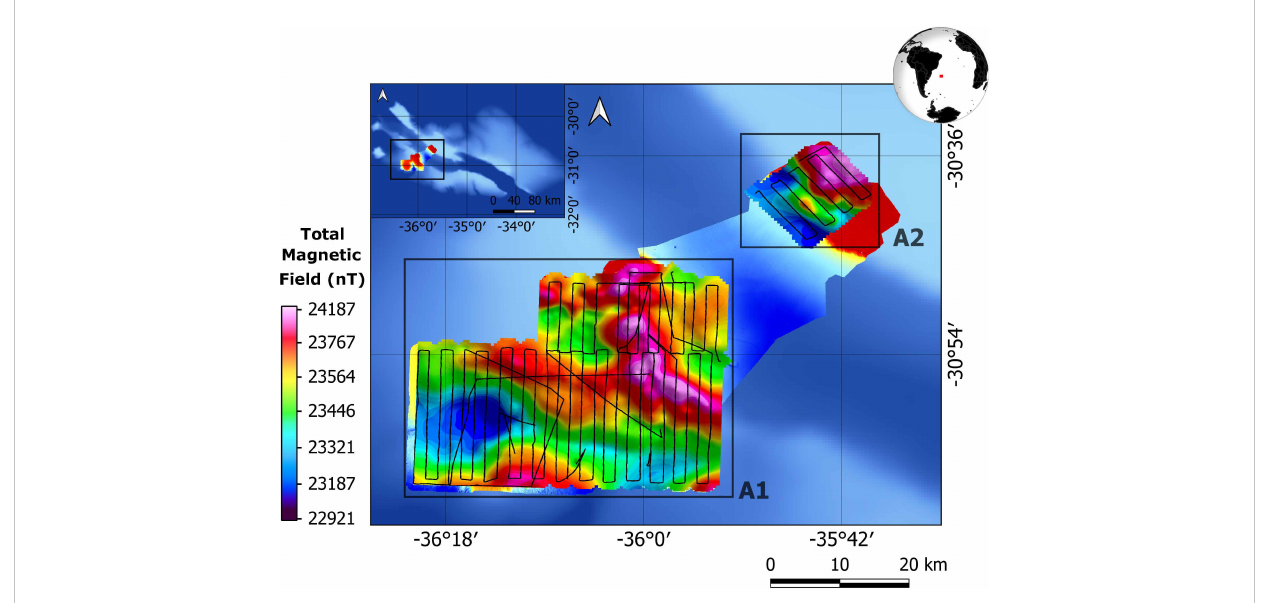
FIGURE 6 Total intensity magnetic fi eld map in nanoteslas (nT), acquired during the RGR-1 cruise in the northern segment of the Cruzeiro do Sul Rift (NCSR) (areas A1 and A2). The acquisition lines have 2 km spacing, and the grid cell size is 450